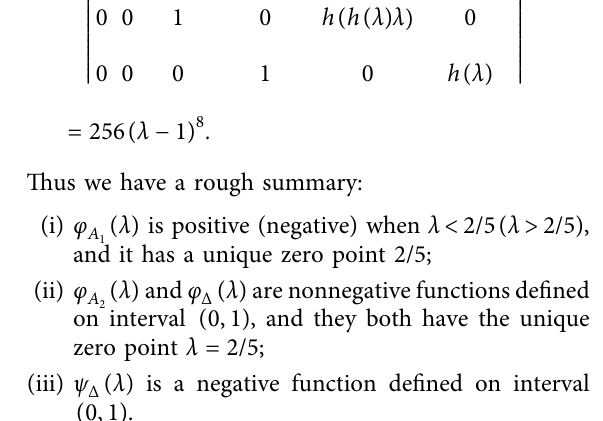
( λ ) on the interval [ 0 , 1 ] ; (c) figure of function φ A 2